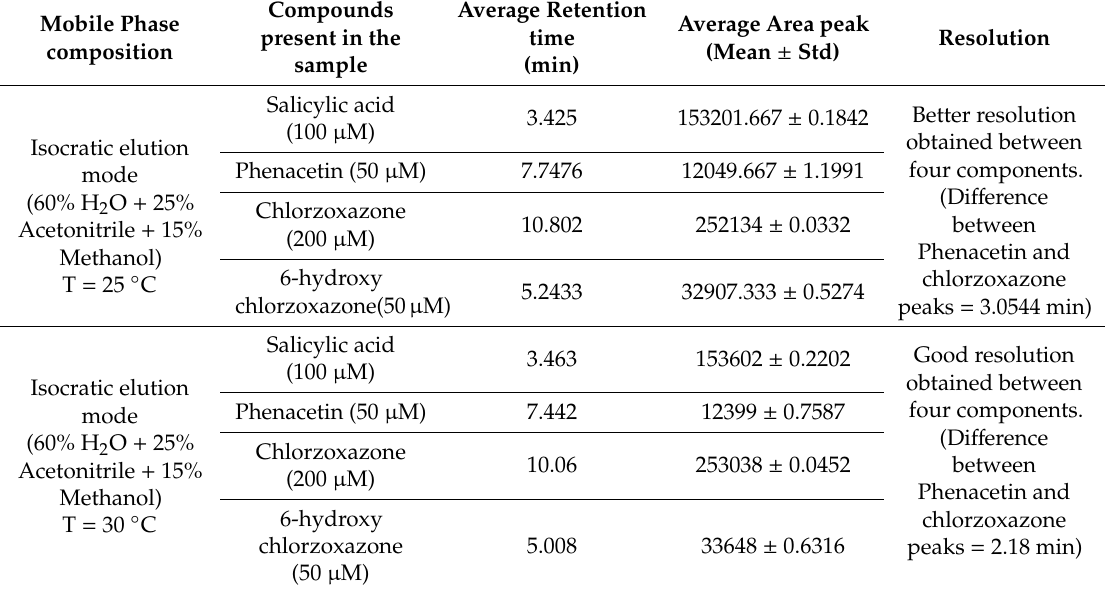
Table A5. Variation in area peak, retention time of each CYP2E1 compounds when changing the column temperature.